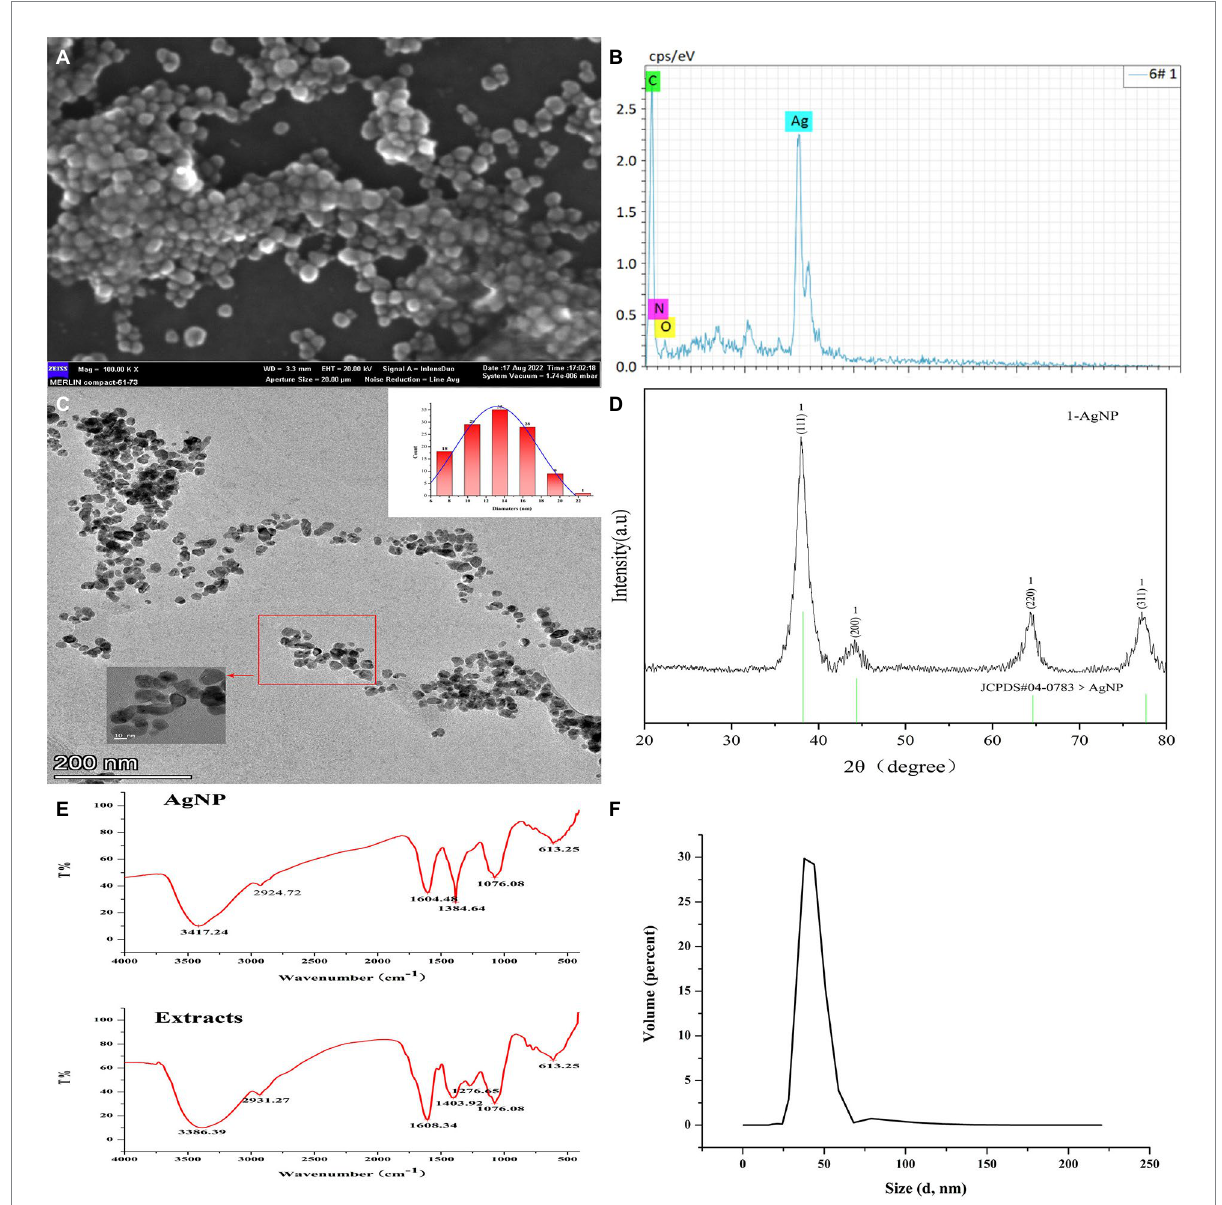
FIGURE 2 Characterization of Mf-AgNPs. (A) SEM image of AgNPs; (B) EDS result; (C) HR-TEM image and particle size distribution of AgNPs; (D) XRD results; (E) FTIR spectrum of AgNPs; (F) DLS measure